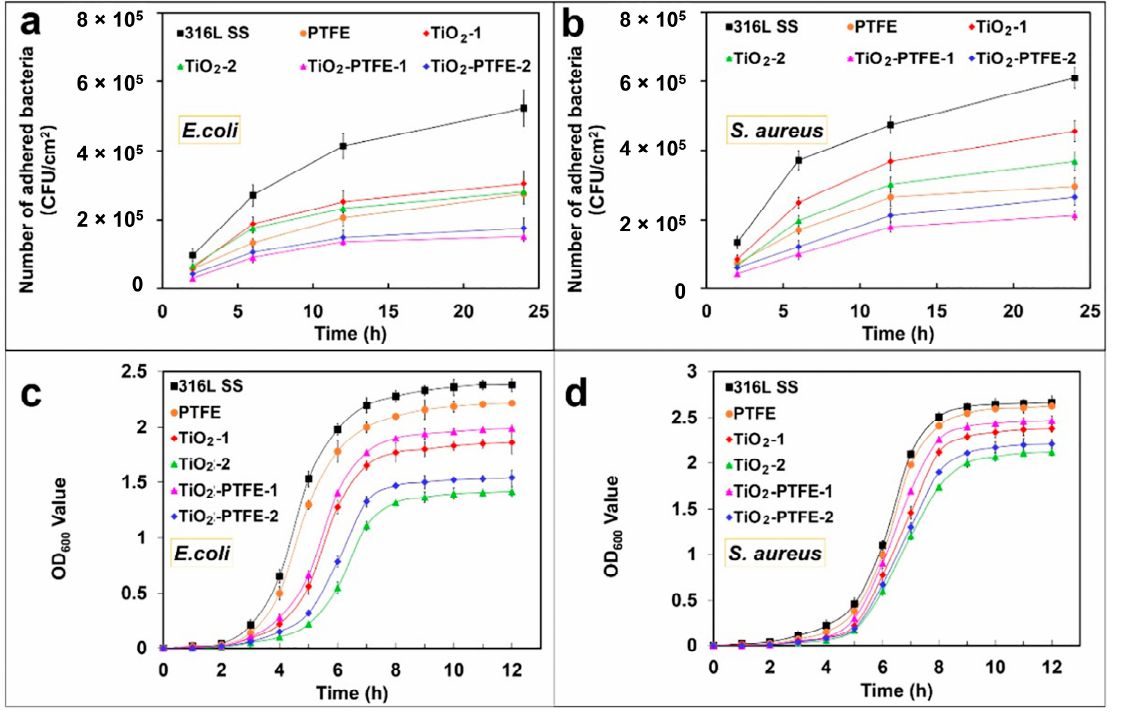
Figure 2. Effect of bacterial adhesion ( a , b ) and bacterial growth of E. coli and S. aureus pathogens on TiO 2 -PTFE coated and uncoated substrates [164]. TiO 2 -PTFE coated substrates exhibit lower bacterial adherence and a significant reduction in bacterial growth ( c , d ) as compared to uncoated